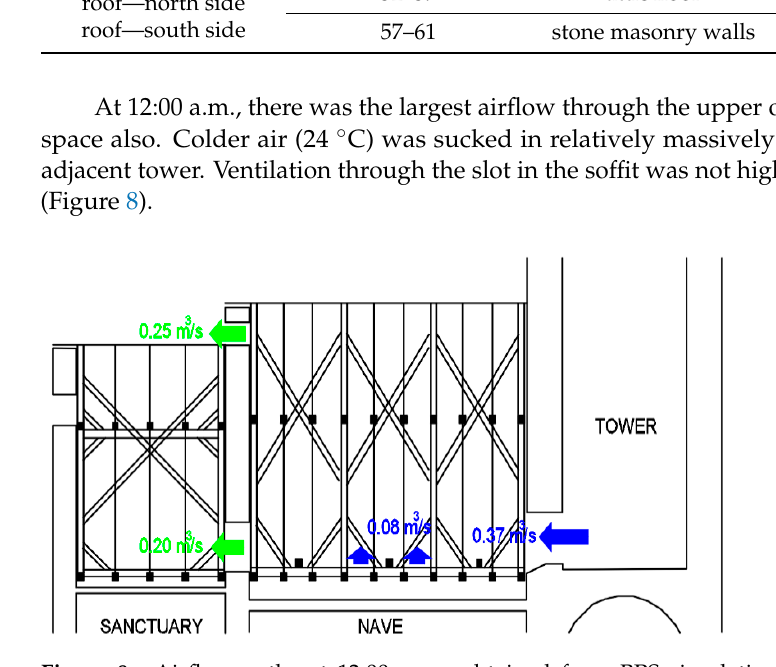
Table 4. Surface temperatures at 12:00 a.m. obtained from BPS simulation.